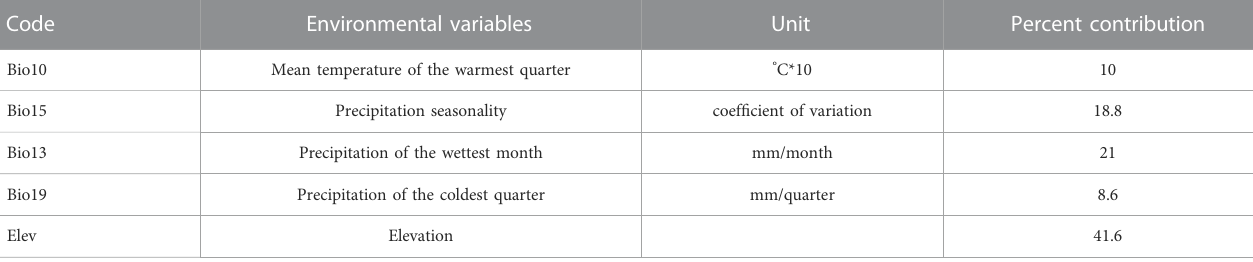
TABLE 2 Environmental variables for Pinus and percent contribution to the